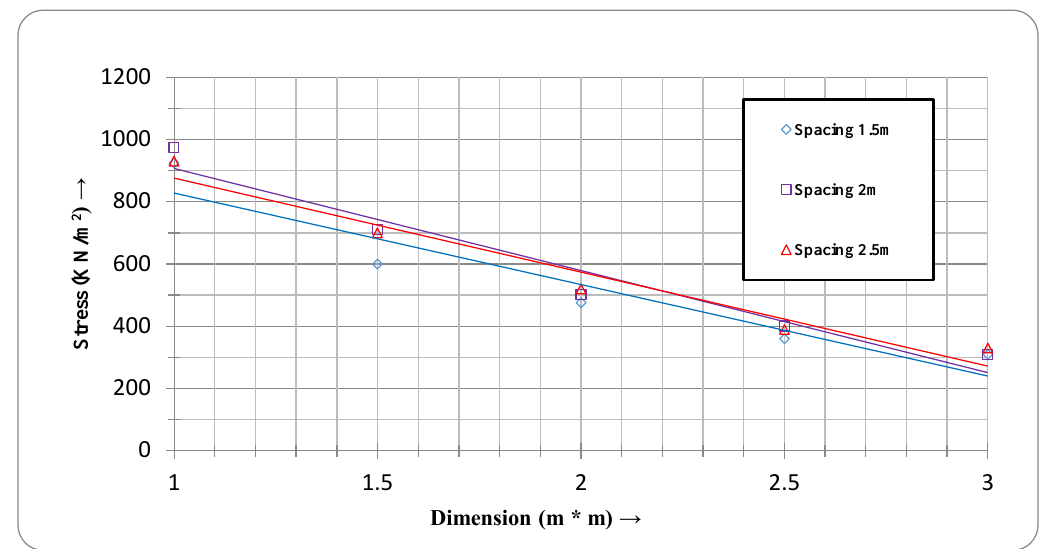
Fig. 20. Stress vs. Dimension graph for different spacing (settlement 50 mm fixed). Fig. 20 represents the combined graph of Stress vs. Dimension for allowable settlement of